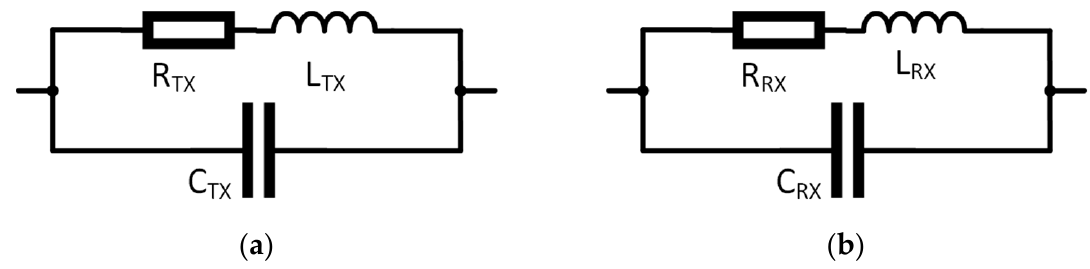
Figure 6 . Equivalent circuit parameters model: ( a ) transmitter and ( b ) receiver. Figure 6. Equivalent circuit parameters model: ( a ) transmitter and ( b ) receiver. Table 1. Transmitter and receiver equivalent circuit parameters.